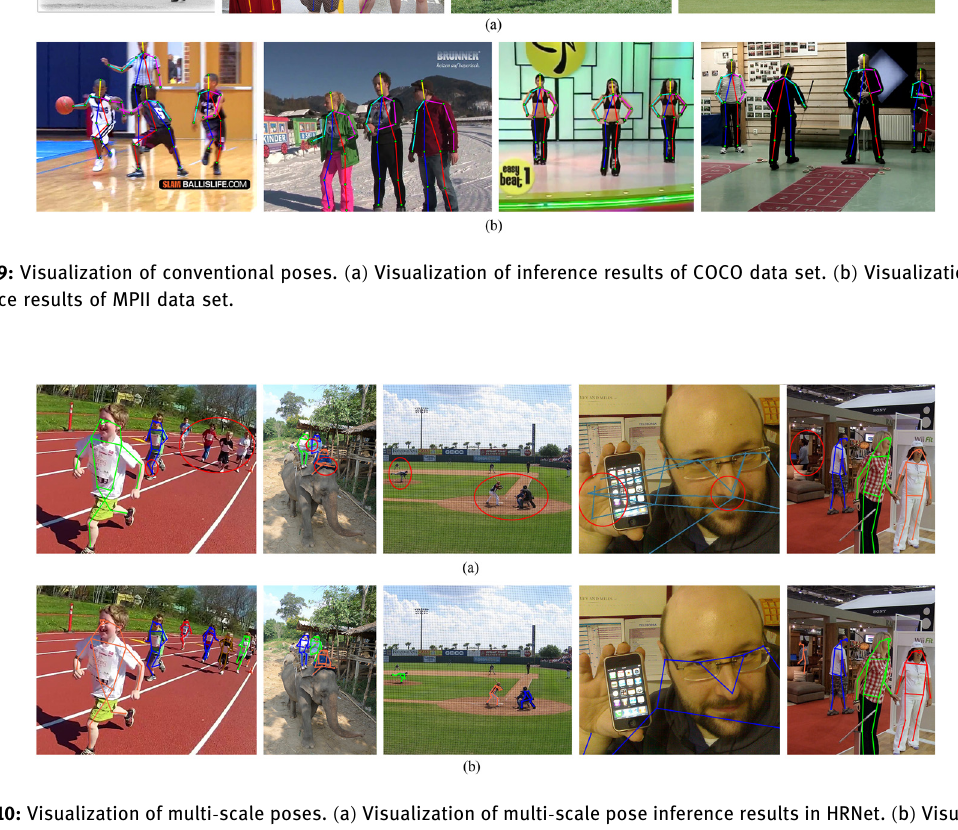
Figure 10: Visualization of multi - scale poses. ( a ) Visualization of multi - scale pose inference results in HRNet. ( b ) Visualization of multiscale pose inference results in our CRNet.